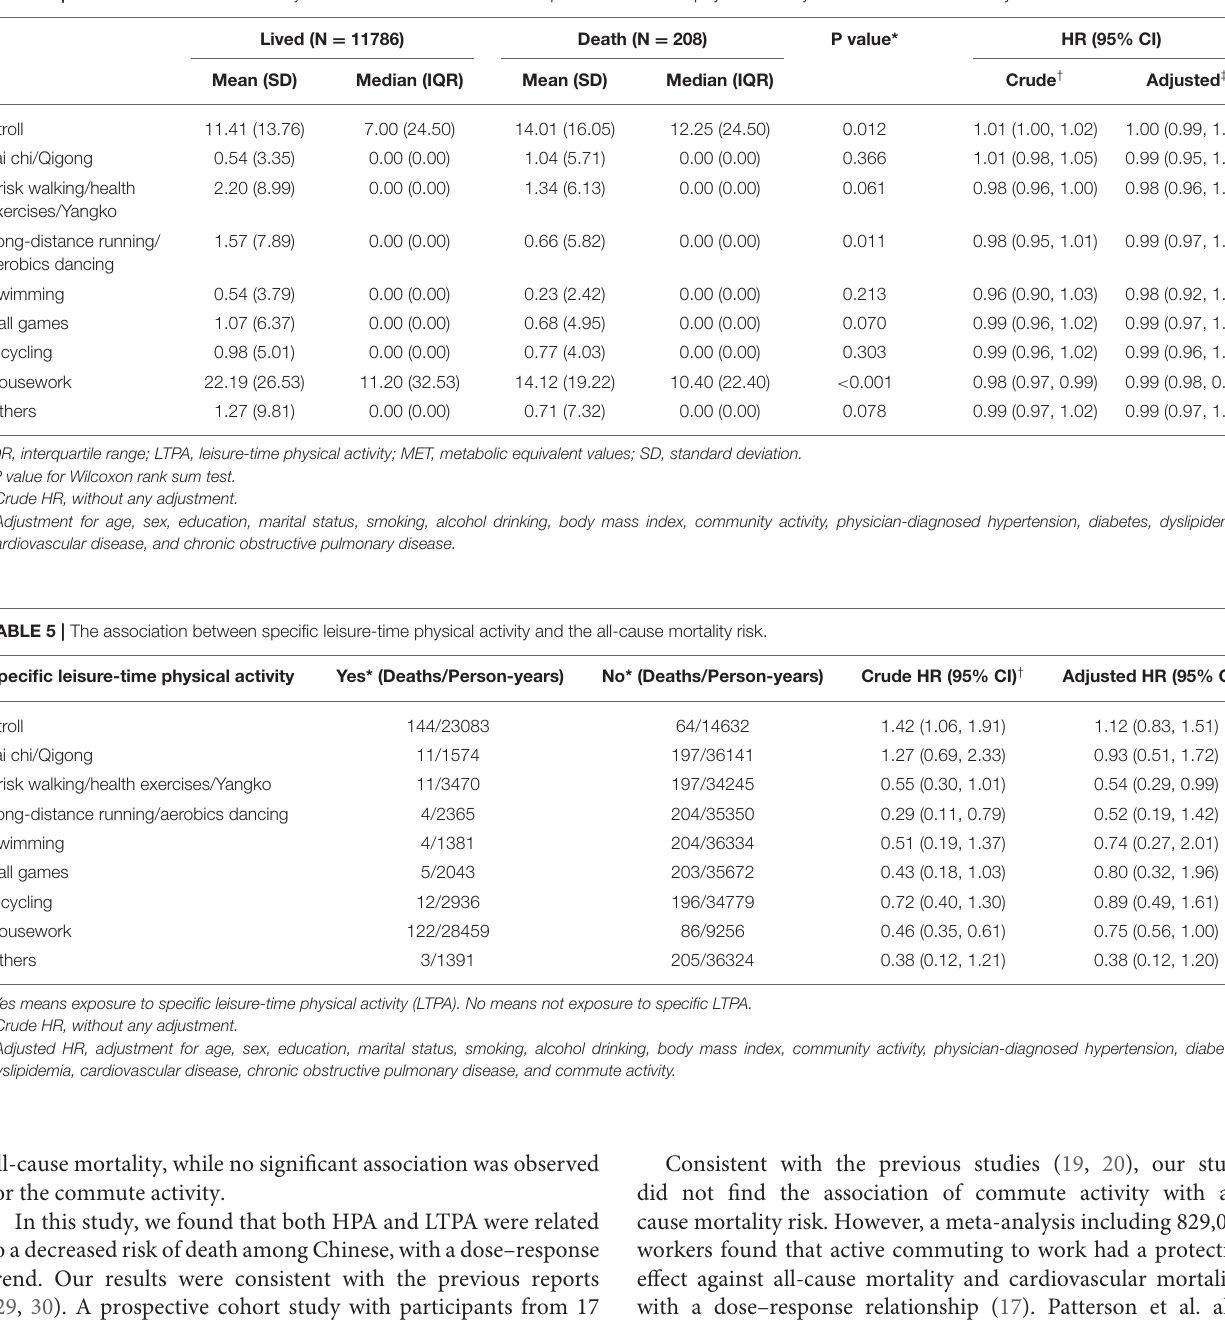
TABLE 4 | The association between every 1 MET-hour/week increment of specific leisure-time physical activity and the all-cause mortality risk.